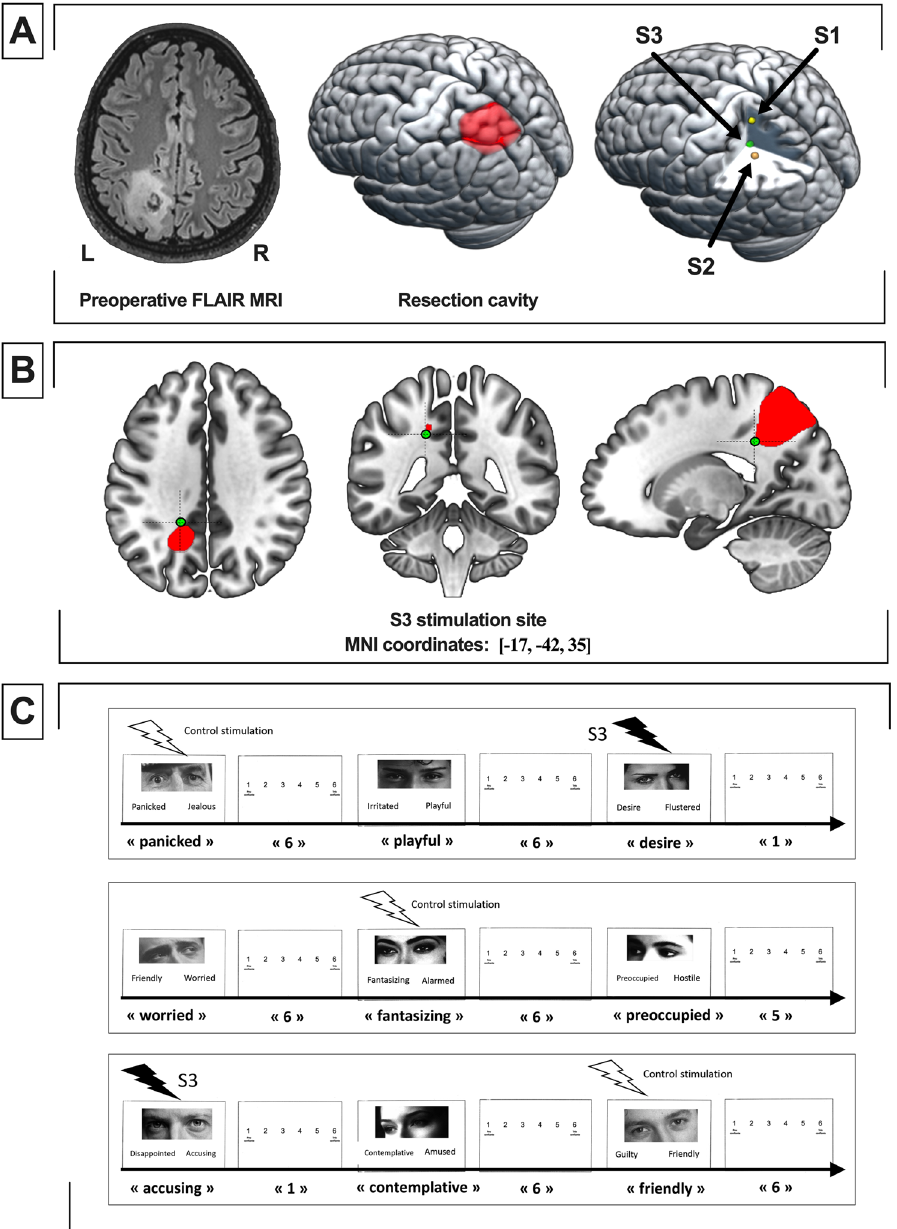
Figure 5. Case illustration 2. S1: Illustrative stimulation 1, generating right leg dysesthesias and thrilling. S2: Illustrative stimulation 2, generating anomia. S3: Illustrative stimulation 3, generating a dissociation between the Read the mind in the Eyes task and the self-confidence index task. ( A ) Preoperative FLAIR MRI axial sequence (left), 3D rendering of the resection cavity (center) and 3D rendering of the stimulation points S1, S2 and S3. ( B ) Axial (left), coronal (center) and sagittal (right) location of S1 stimulation site. The cavity of resection is presented in red. ( C ) Schematic description of the intraoperative protocol (read the mind in the Eyes task and self-confidence index